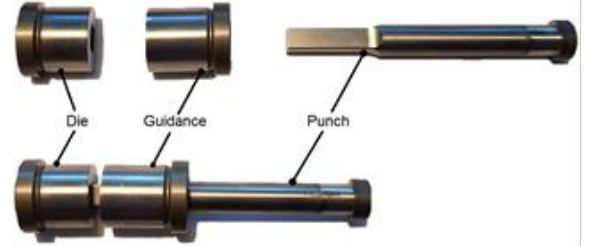
Figure 2. Active tool elements used in the experiments.